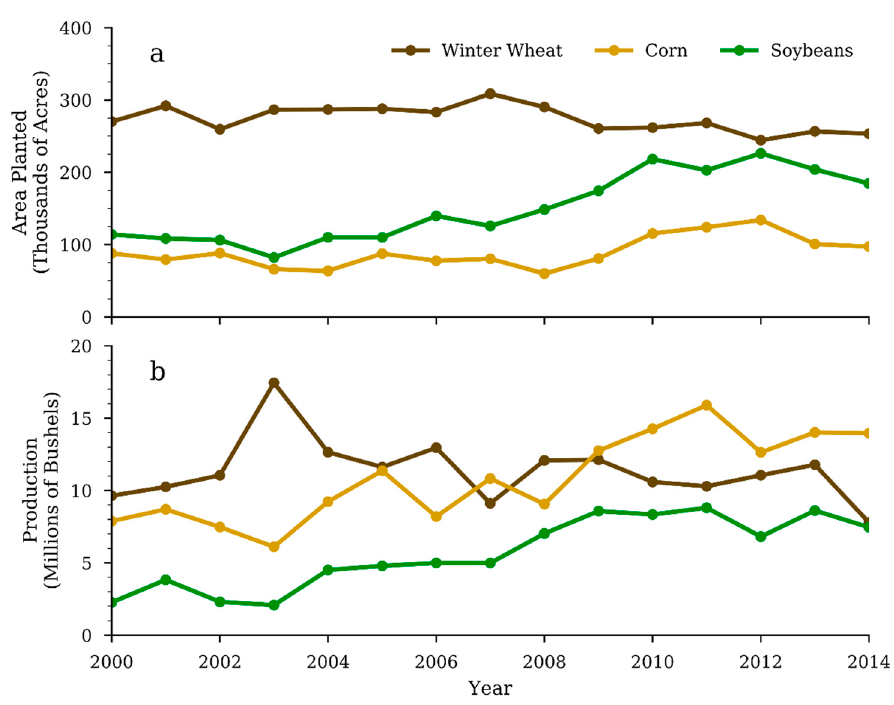
Figure 2. The annual planted acreage ( a ) and production in bushels ( b ) for corn, winter wheat, and soybeans in the HCW.